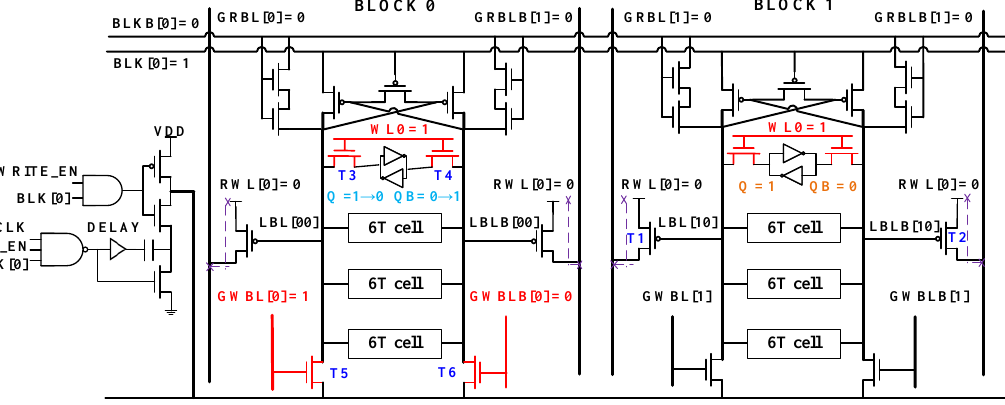
Figure 3. Half-Select Condition operation of local bit-line SRAM.